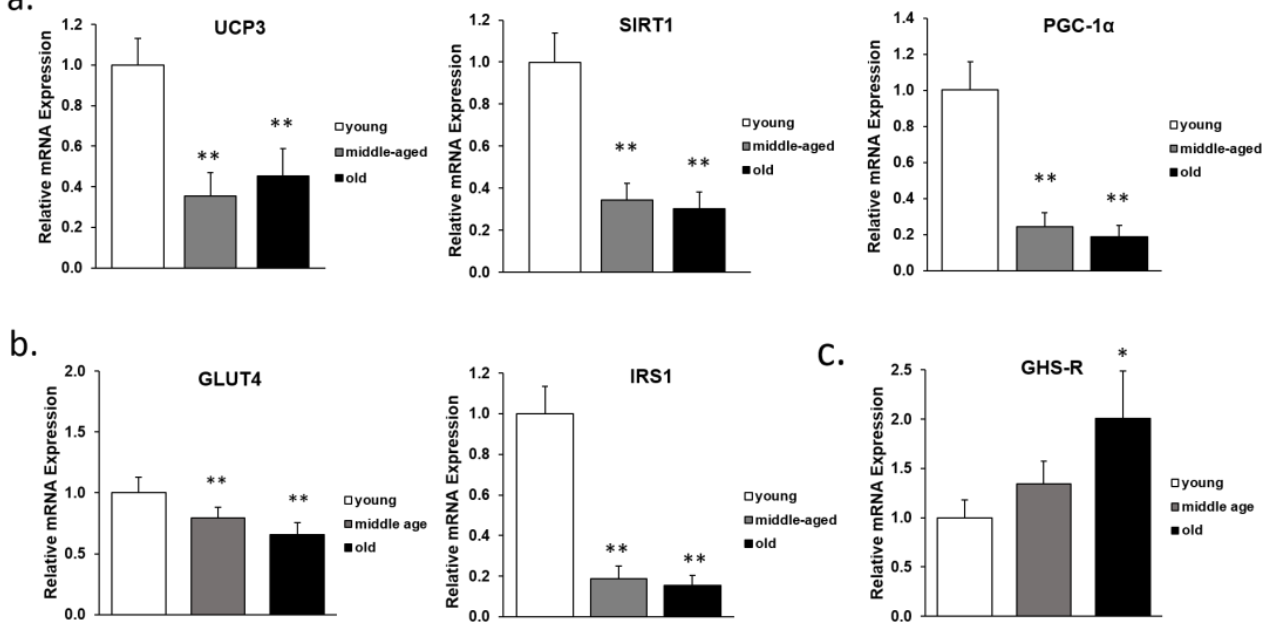
Figure 1. Relative mRNA expression in gastrocnemius muscle during aging. Young (4–5 m), middle- aged (12‒1 4 m ) and old (18‒2 6 m) male C57BL/6 J mice were used. ( a ) Relative mRNA expression of mitochondrial functional markers of UCP3 , SIRT1 and PGC- 1α ; ( b ) relative gene expression of glucose transporter marker GLUT and insulin signaling marker IRS1 ; ( c ) relative gene expression of GHS-R . 18s and β -actin house-keeping genes were used as internal controls in qPCR analysis. One-